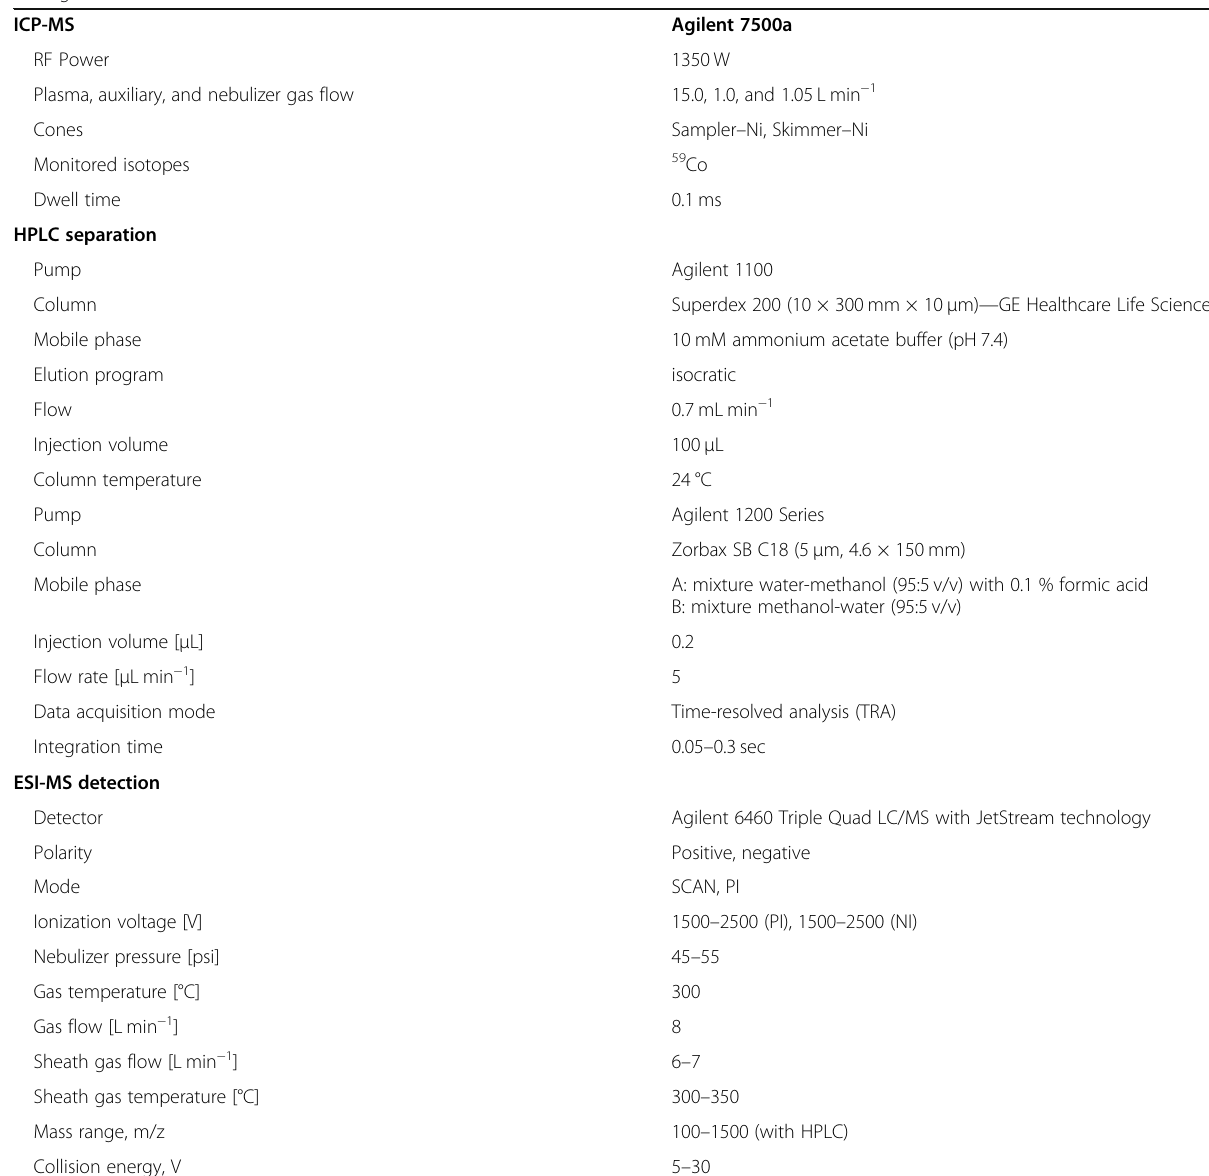
Table 1 Operational parameters for HPLC, ICP-MS, and ESI-MS